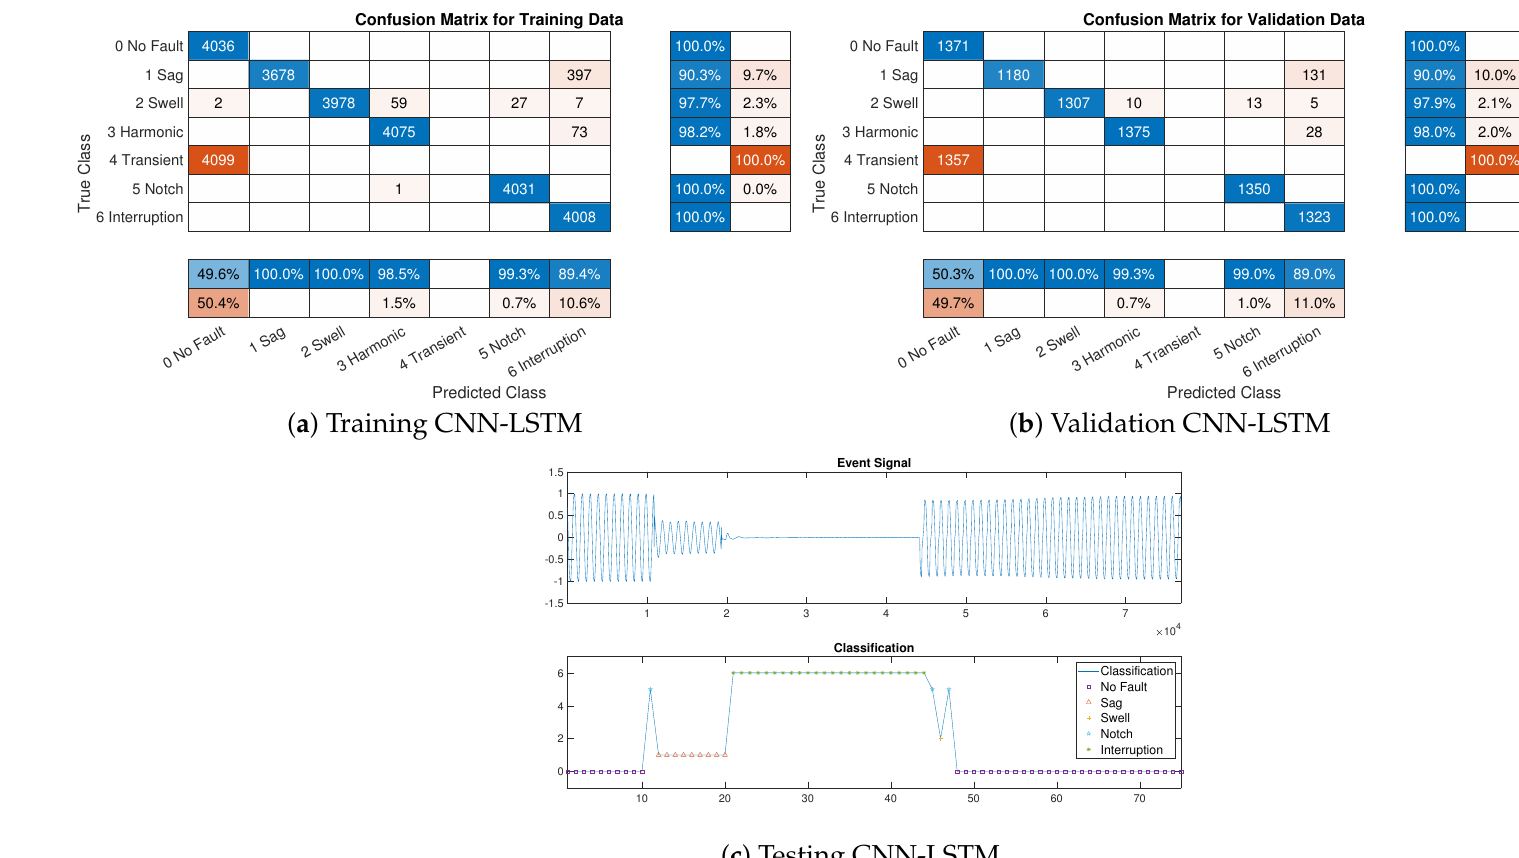
Figure 11. ( a ) Confusion matrix of the CNN-LSTM training, ( b ) Confusion matrix of the CNN-LSTM validation, ( c ) Testing of the CNN-LSTM using a simulated voltage waveform.